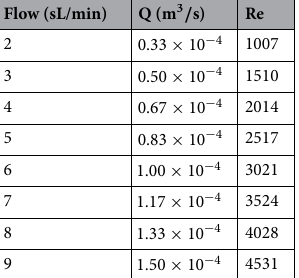
Table 1. Gas parameters and Reynolds number for various flow rates of